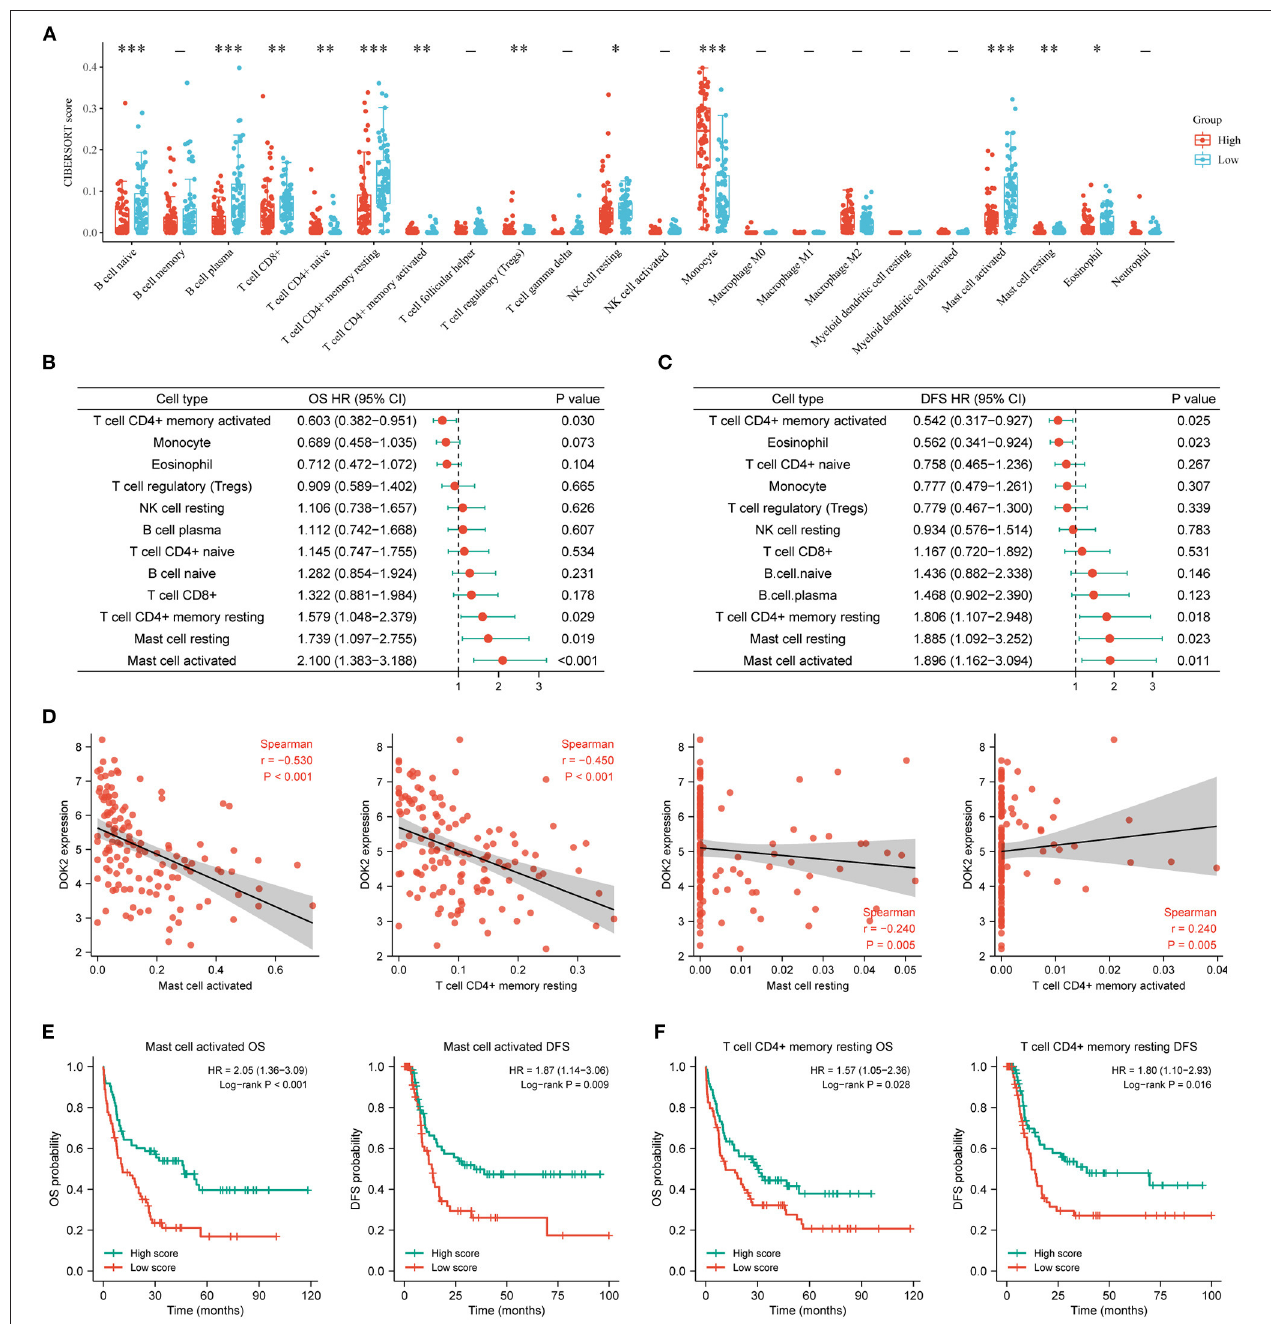
FIGURE 7 | Associations of DOK2 with CIBERSORT immune cell types in TCGA datasets. (A) The CIBERSORT score distribution between DOK2 high and DOK2 low groups. (B) Forest plots of significant immune cell types for OS using univariate Cox analysis (low vs. high with high as reference). (C) Forest plots of significant immune cell types for DFS using univariate Cox analysis (low vs. high with high as reference). (D) Spearman correlation analysis of DOK2 expression with mast cell activated, T cell CD4 + memory resting, mast cell resting, and T cell CD4 + memory activated. (E) Kaplan–Meier survival curves for OS and DFS stratified by immune scores of activated mast cells. (F) Kaplan–Meier survival curves for OS and DFS stratified by immune scores of resting CD4 + memory T cells. * P < 0.05, ** P < 0.01, *** P < 0.001.